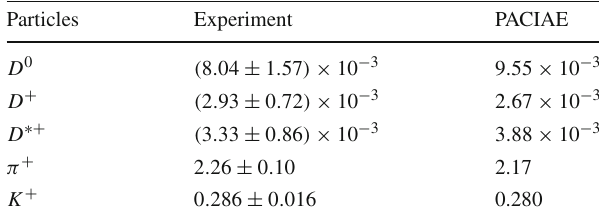
Table1 Theyieldsof D 0 , D + , D ∗+ , π + and K + computedbyPACIAE √ s = 7 TeV and comparison model in mid-rapidity pp collisions at with experimental data [40,41], with the 0 < p T < 36 GeV/c for D 0 , 1 < p T < 24 GeV/c for D + and D ∗+ , 0 . 1 < p T < 3 GeV/c for π + , and 0 . 2 < p T < 6 GeV/c for K